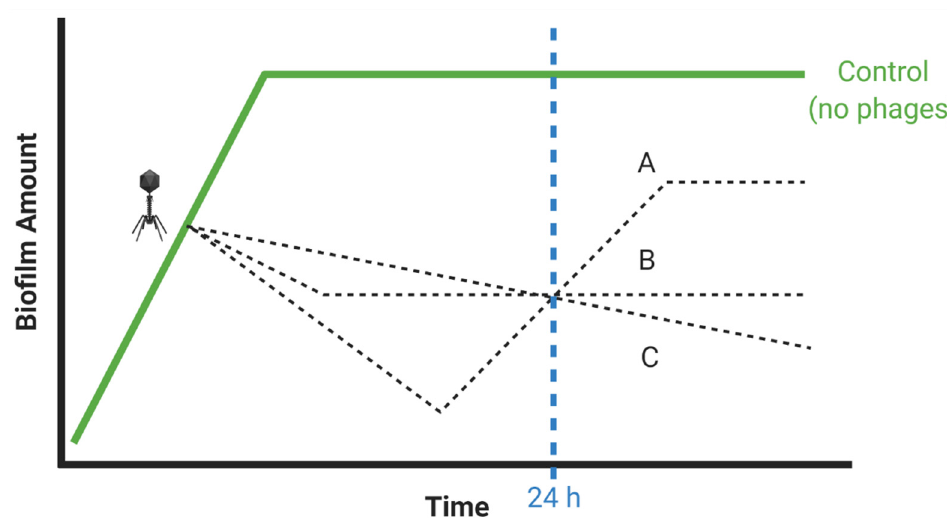
Figure 5 for illustration of treatment outcomes that may be distinguished by taking multiple rather than only single time points.